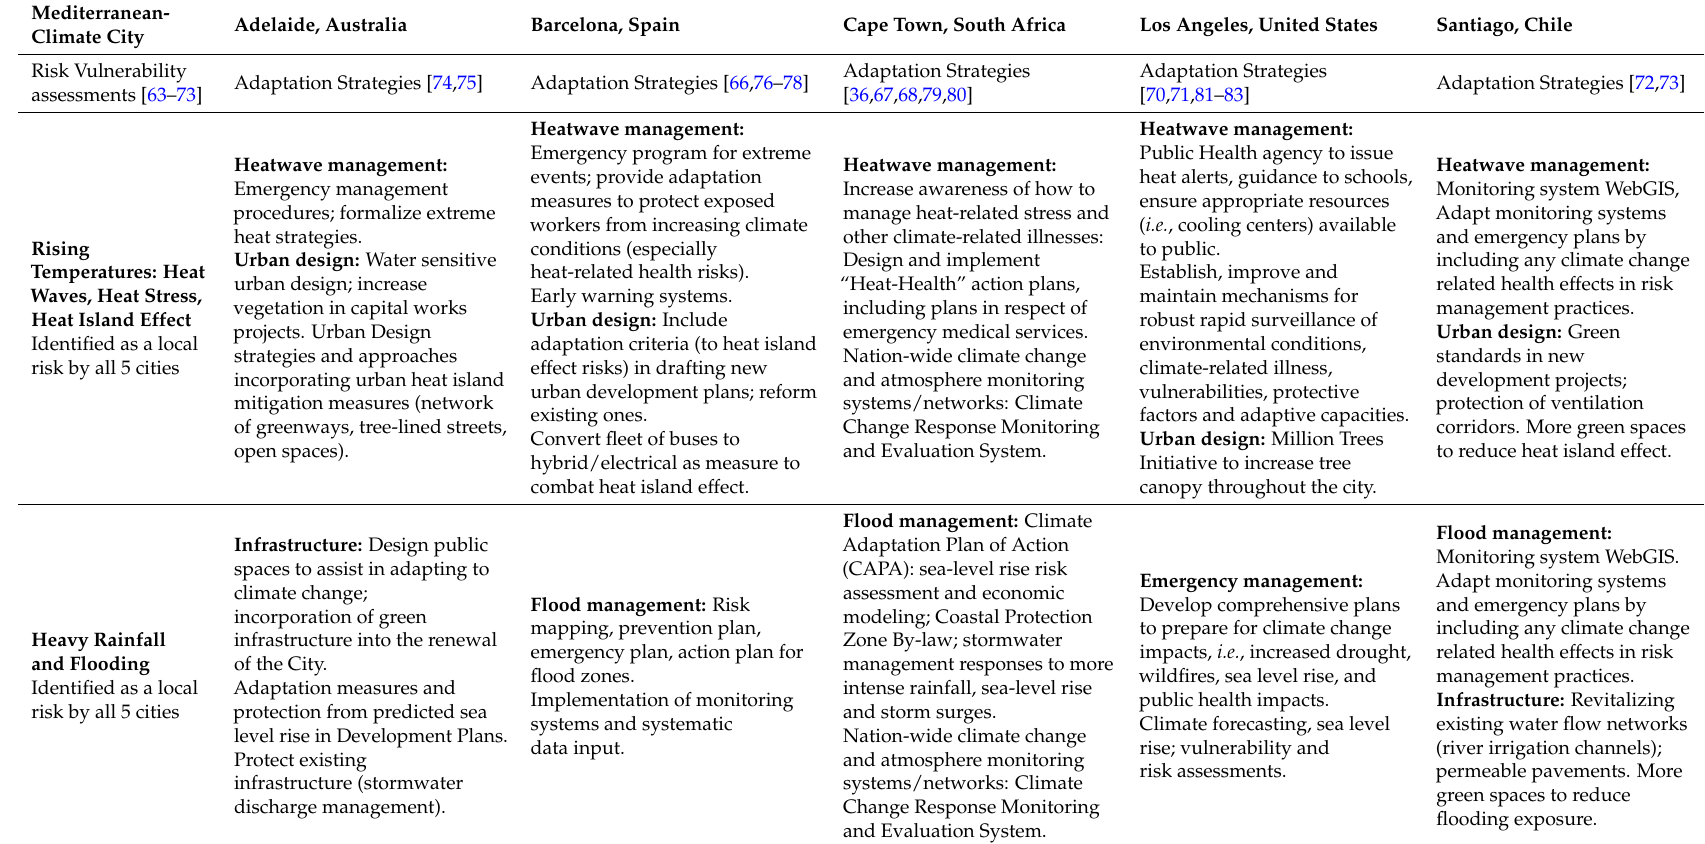
Table 2. Climate Action Plans in the five Med-cities, analyzed according to the expected health impacts of climate change on city dwellers in local and national vulnerability